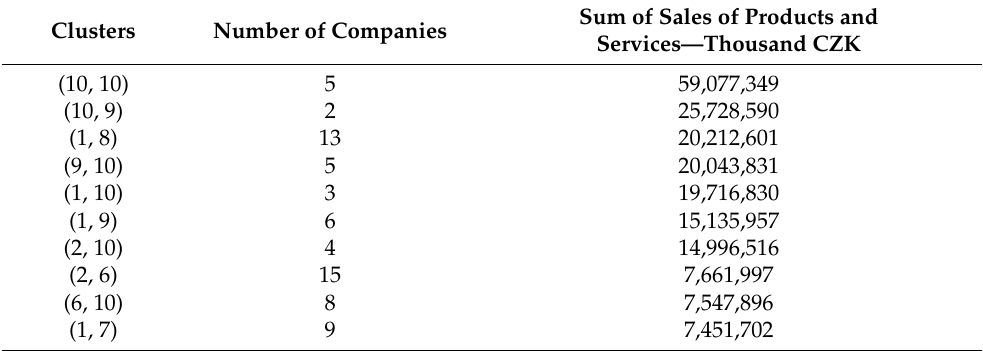
Table 19. Table of ten clusters with the highest total sum of fixed assets for the year 2017.